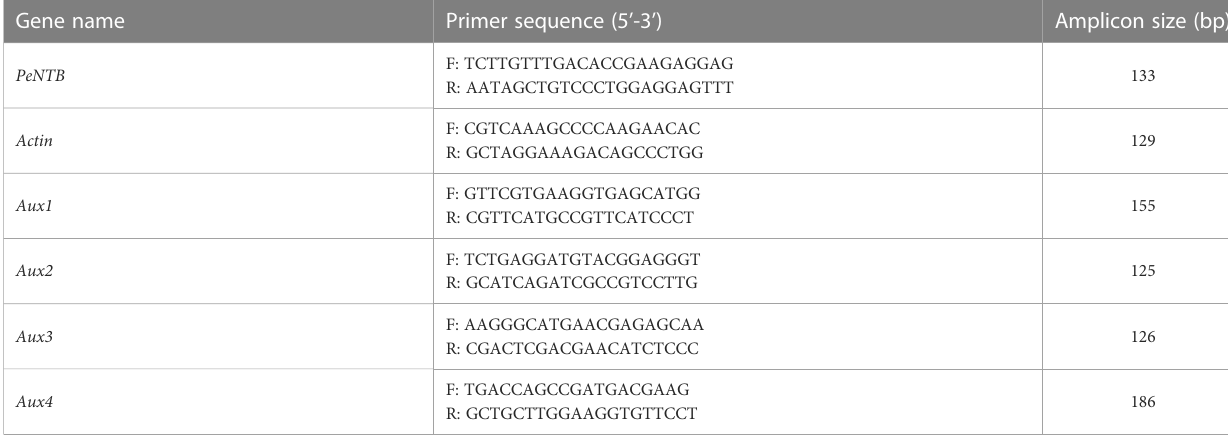
TABLE 1 Speci fi c primers used for